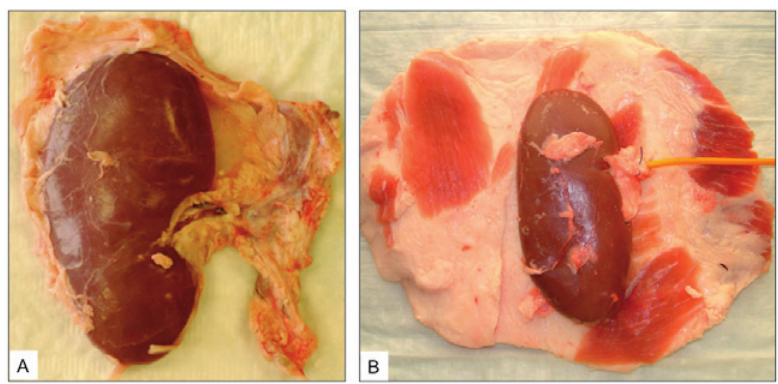
Figure 1 - Freshly harvested porcine kidney (A) and full thickness skin flap used to cover the kidney (B).